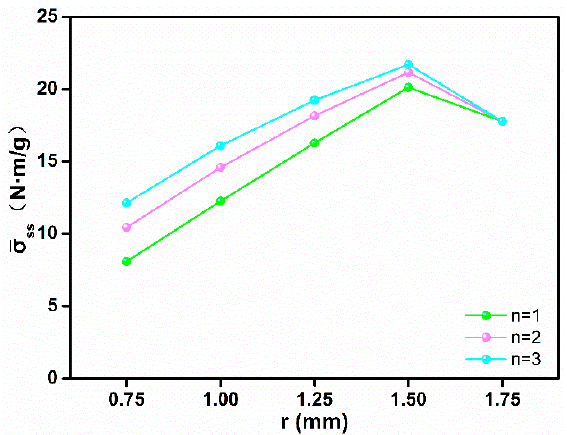
Figure 10. The specific strength of the 2-D lattice structure with the variable cross-section core.